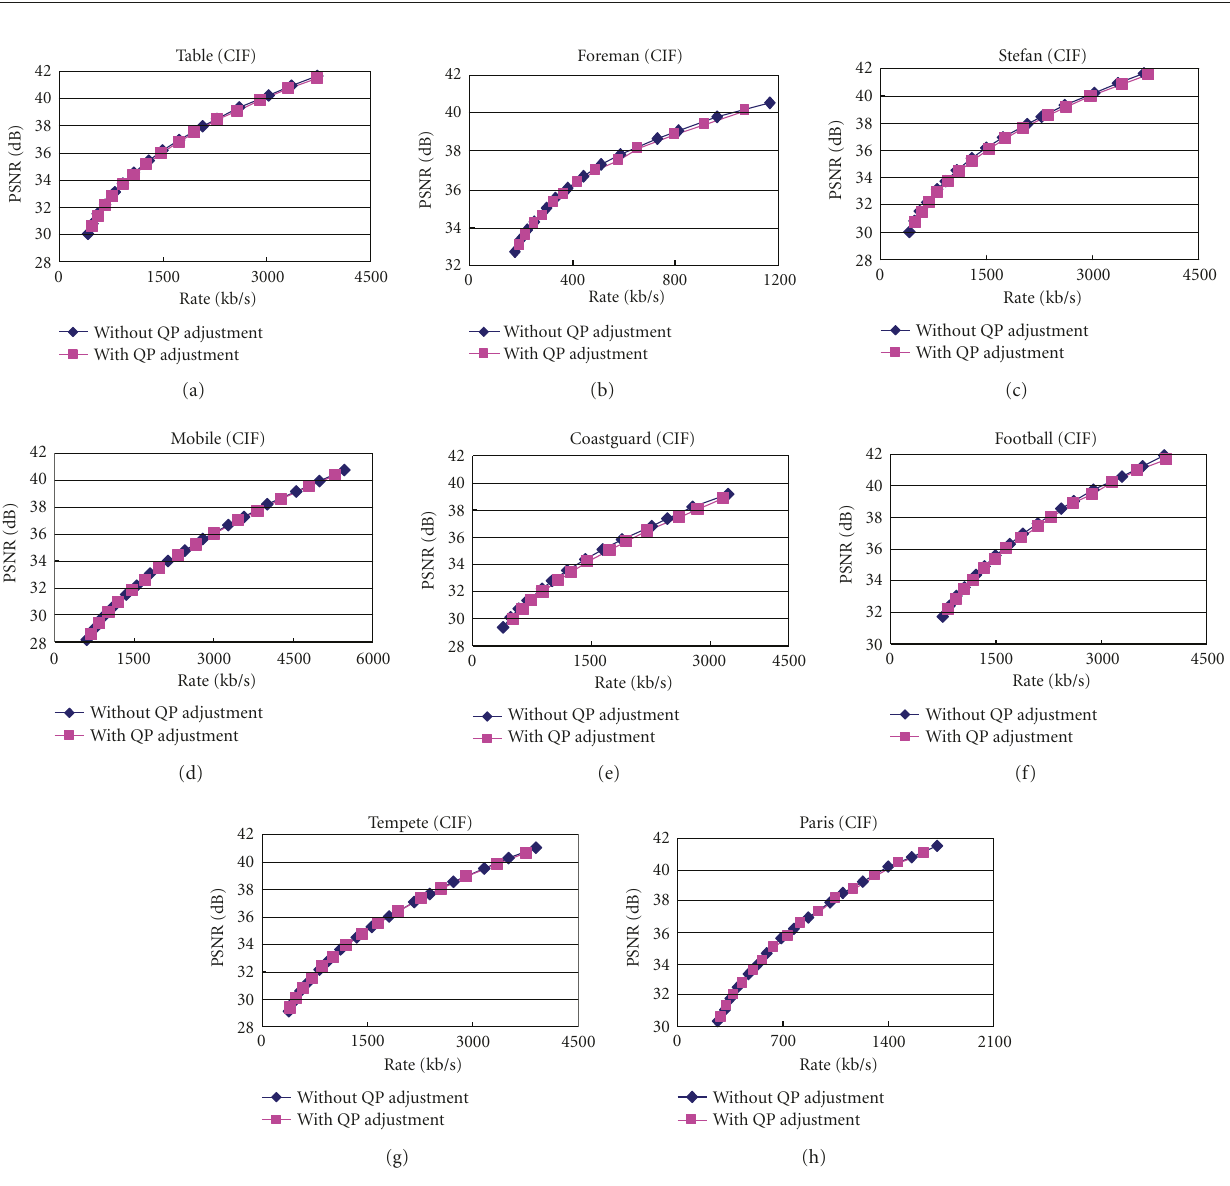
Figure 6: Encoding performance comparison between with and without QP